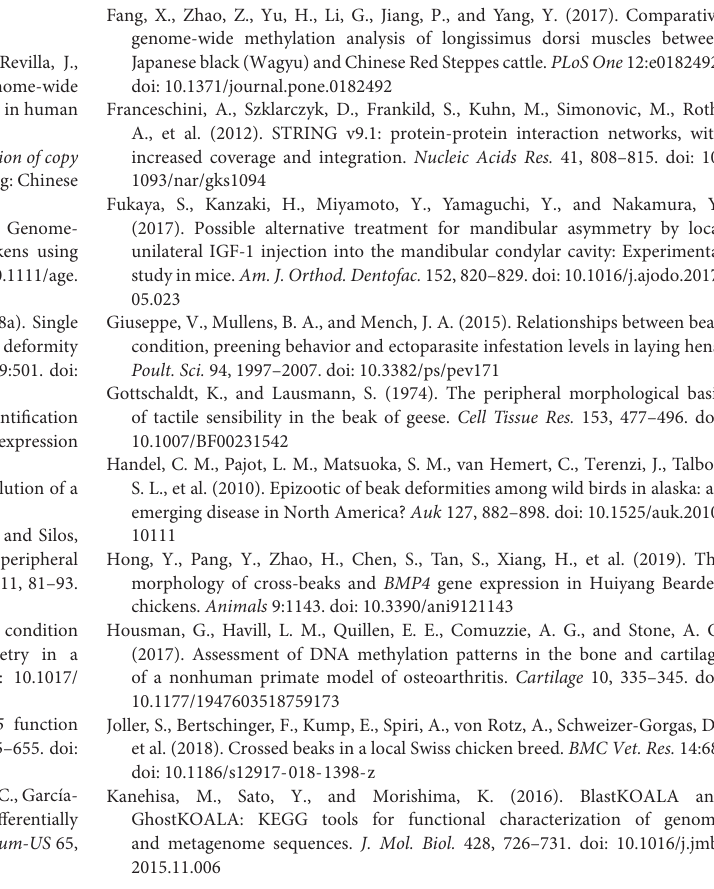
Supplementary Table 4 | The list of DMGs enriched GO terms for CG context. Supplementary Table 5 | The list of DMGs enriched top 20 KEGG pathways for CG context. Supplementary Table 6 | The list of DMGs enriched GO terms for CHH context. Supplementary Table 7 | The list of DMGs enriched top 20 KEGG pathways for CHH context. Supplementary Table 8 | The list genes were identified as both DEGs and DMGs in the left-side (affected-side) and the right-side (nor-mal-side) mandibular condyle of crossed beak